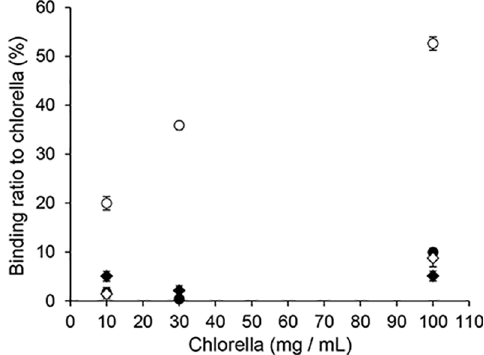
Fig 1. Adsorption of radionuclides to Chlorella . Binding ratios of 85 Sr at pH 1.2 (closed circles), 85 Sr at pH 6.8 (open circles), 137 Cs at pH 1.2 (closed diamonds), or 137 Cs at pH 6.8 (open diamonds) to Chlorella depended on the Chlorella concentration. Data are expressed as the mean ± SD of three samples.